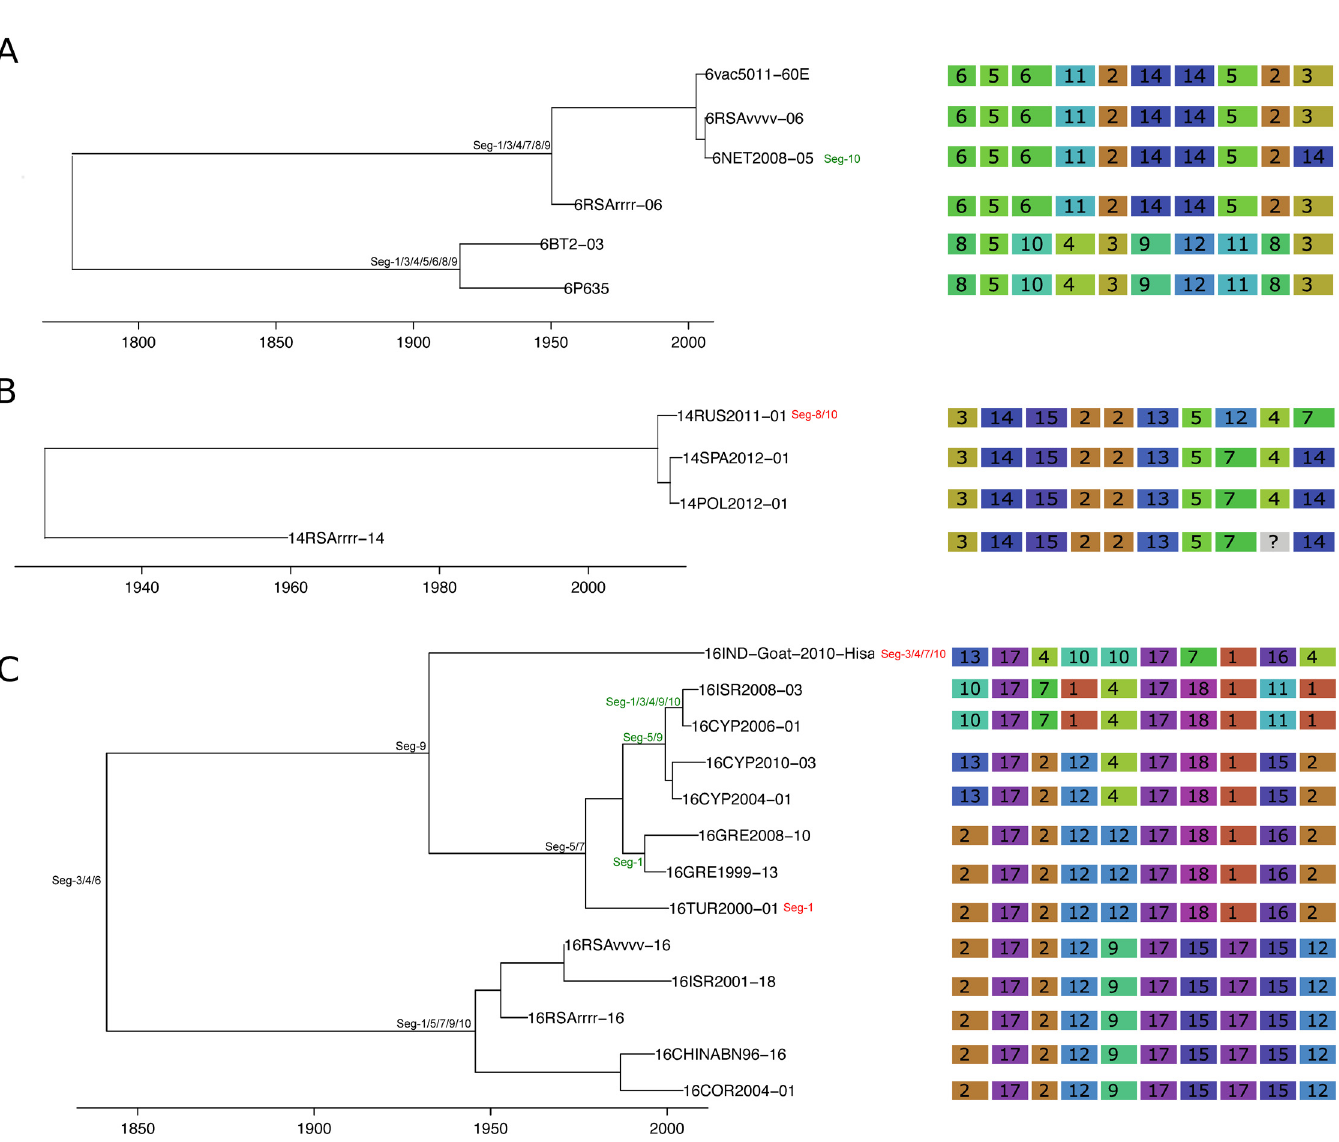
Fig 7. Time-scaled Seg-2 phylogenies of European isolates of BTV-6 (A), BTV-14 (B), and BTV-16 (C). See Fig 4 for